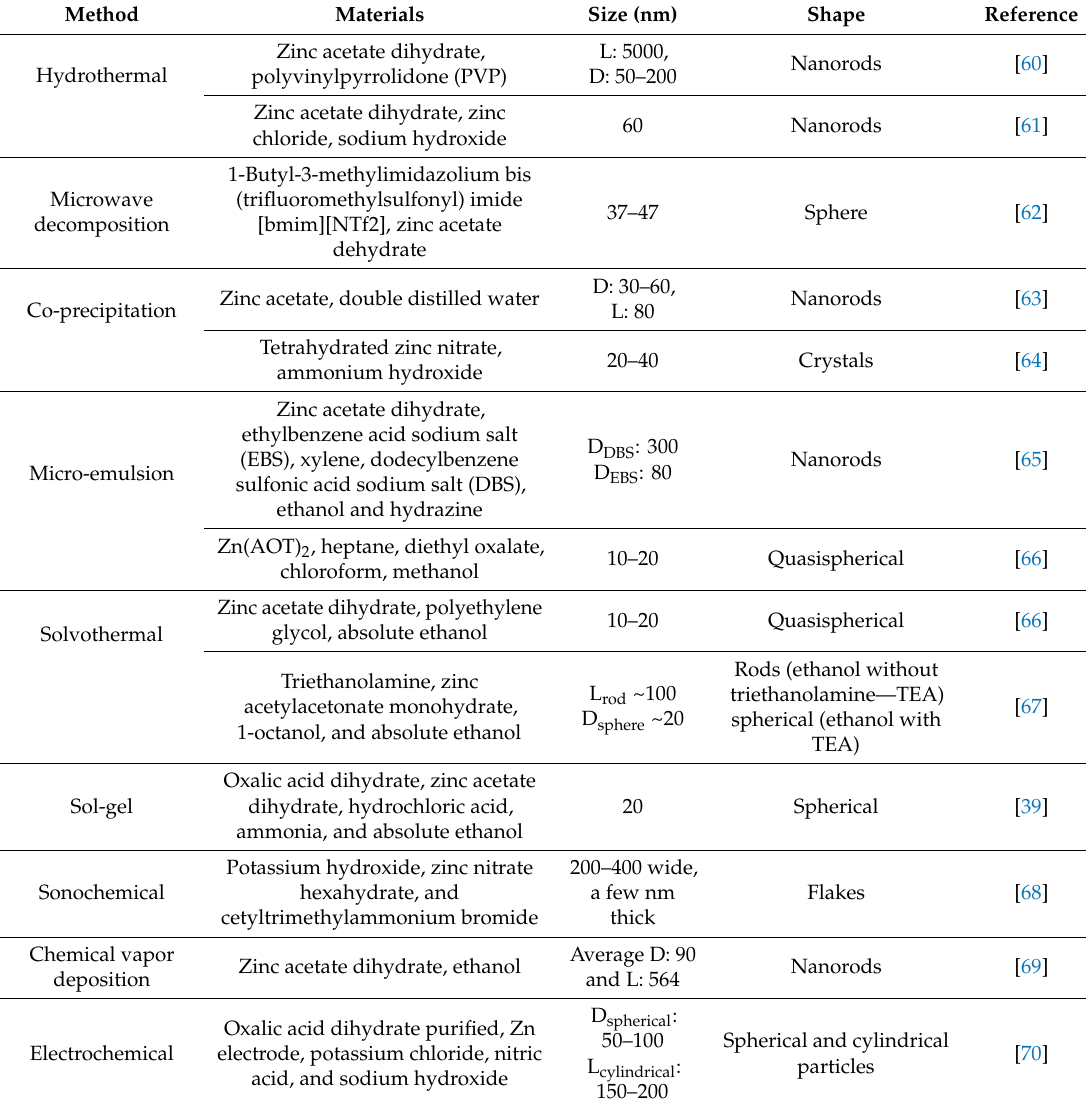
Table 1. Overview of synthesis methods and morphology of zinc oxide (ZnO) nanoparticles